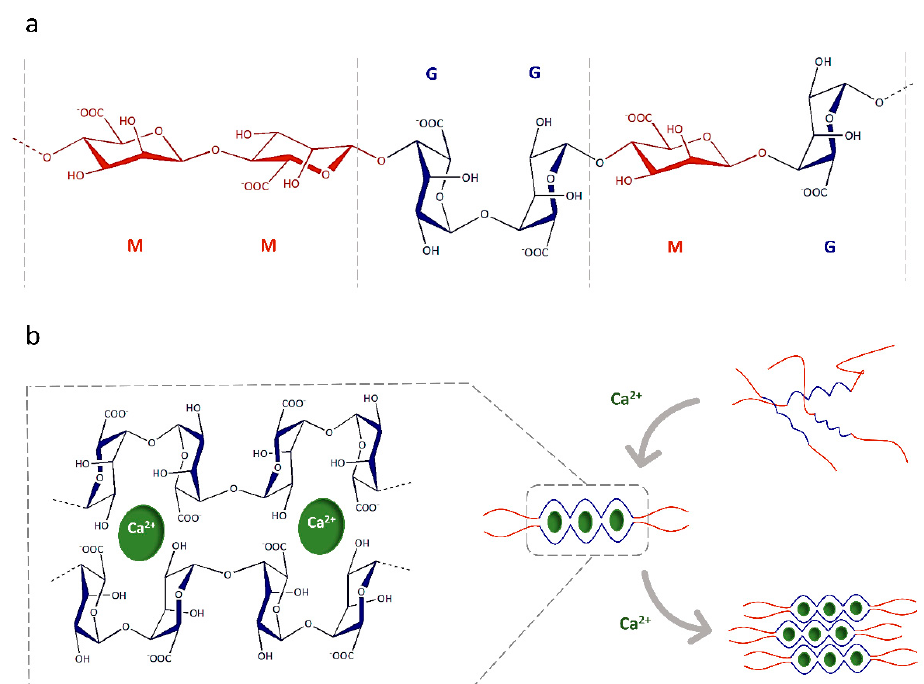
Figure 2. ( a ) Schematized representation of chemical structure of alginate, composed of 1,4 α - L - guluronic acid (G) and 1,4 β - D -mannuronic acid (M) residues, arranged in homo- (MM, GG) or hetero (MG) blocks. ( b ) The junction zone of the “egg-box” model during ionic gelation in the presence of divalent cations (e.g., Ca 2+ ).